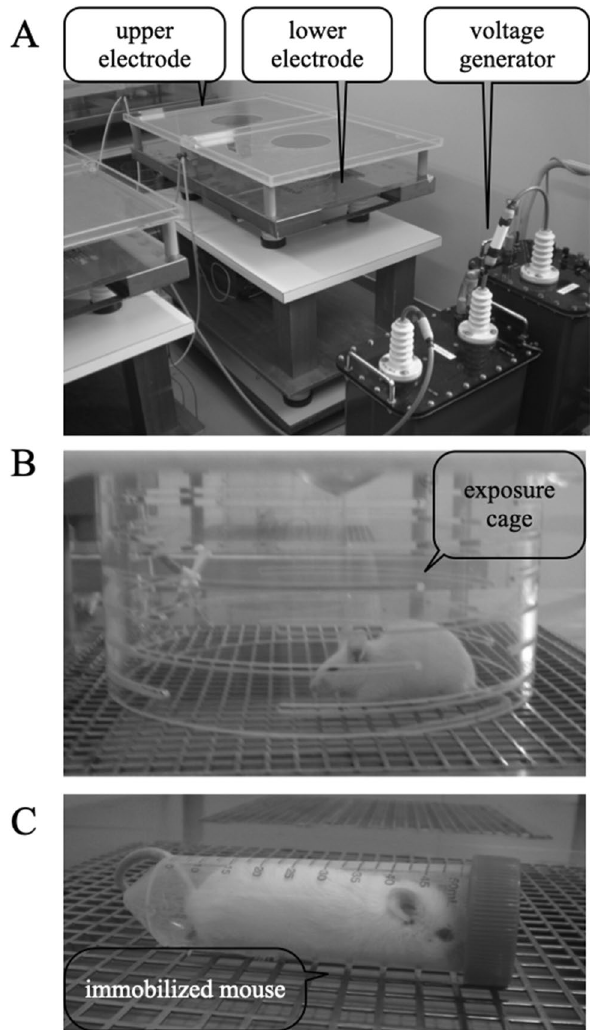
Figure 5. Electric field exposure system. ( a ) Voltage generator and parallel plate electrodes; ( b ) mouse in an exposure cage; ( c ) mouse in the 50-mL centrifuge tube restraining